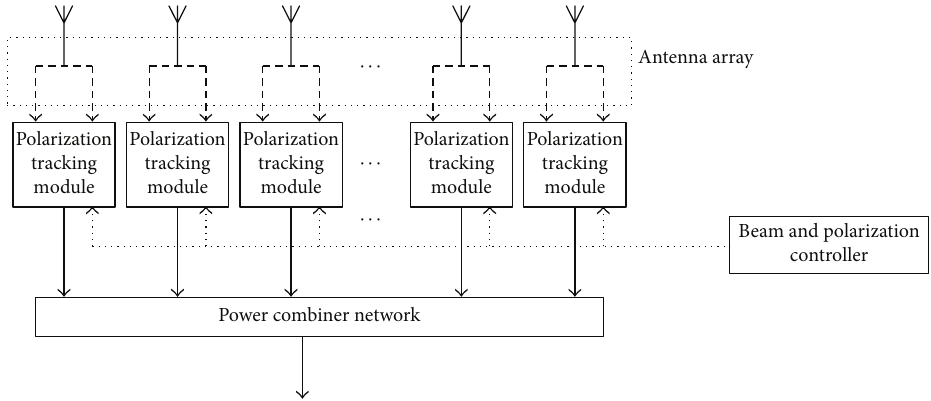
Figure 15: The schematic block diagram of the fabricated polarization tracking active phased array.